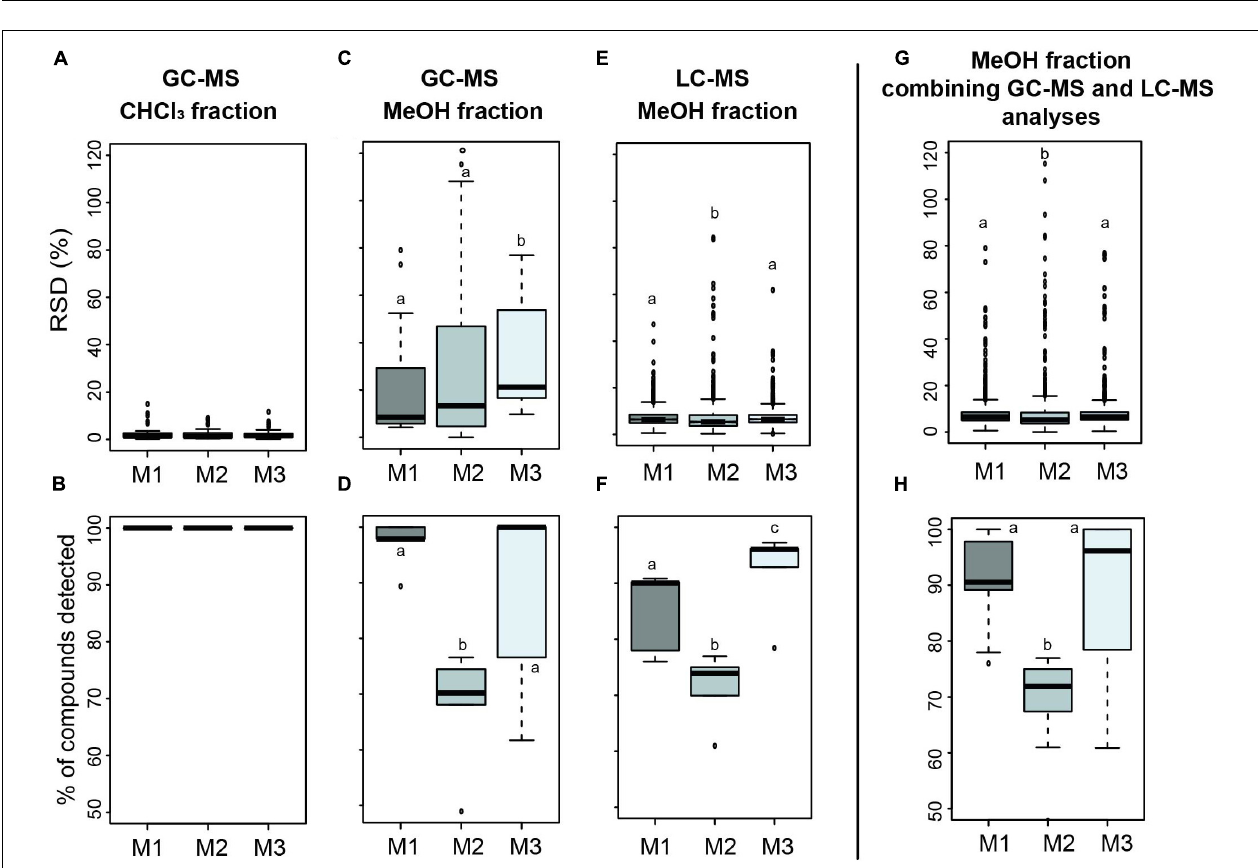
MPB biofilm were then investigated in this CHCl 3 fraction obtained by GC-MS. An unsupervised analysis (PCA) allowed to explain 53.47% of variance on the two first components